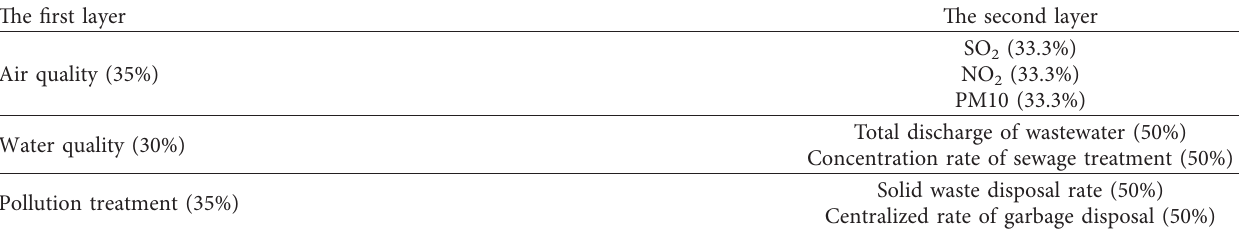
Table 2: Objective evaluation system of environmental